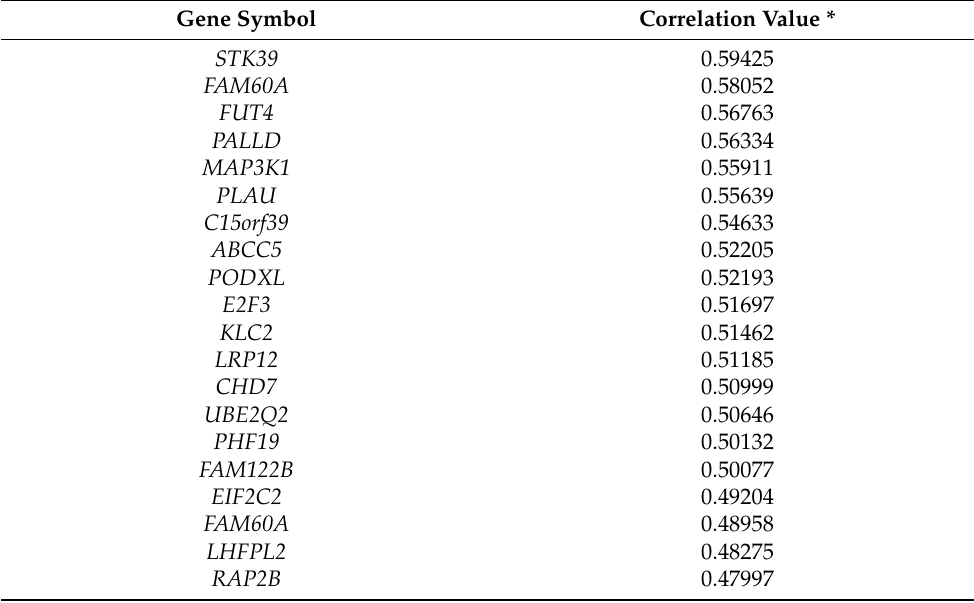
Table 1. Top 20 candidate genes in LINC00152 -driven ceRNA network.